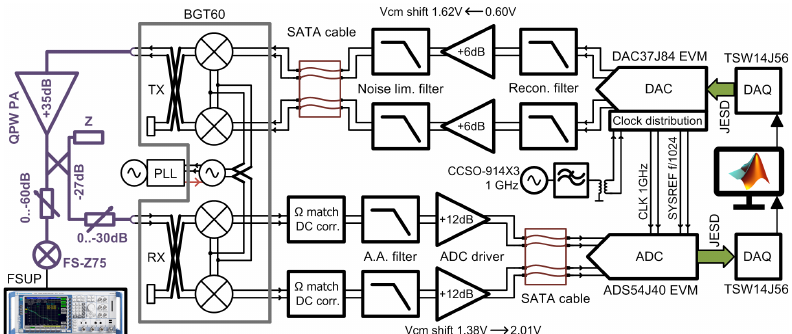
Figure 1. A block diagram of the described mm-wave 60 GHz test-bed. SATA: Serial ATA; ADC: Analog-to-Digital converter; DAC: Digital-to-Analog converter.